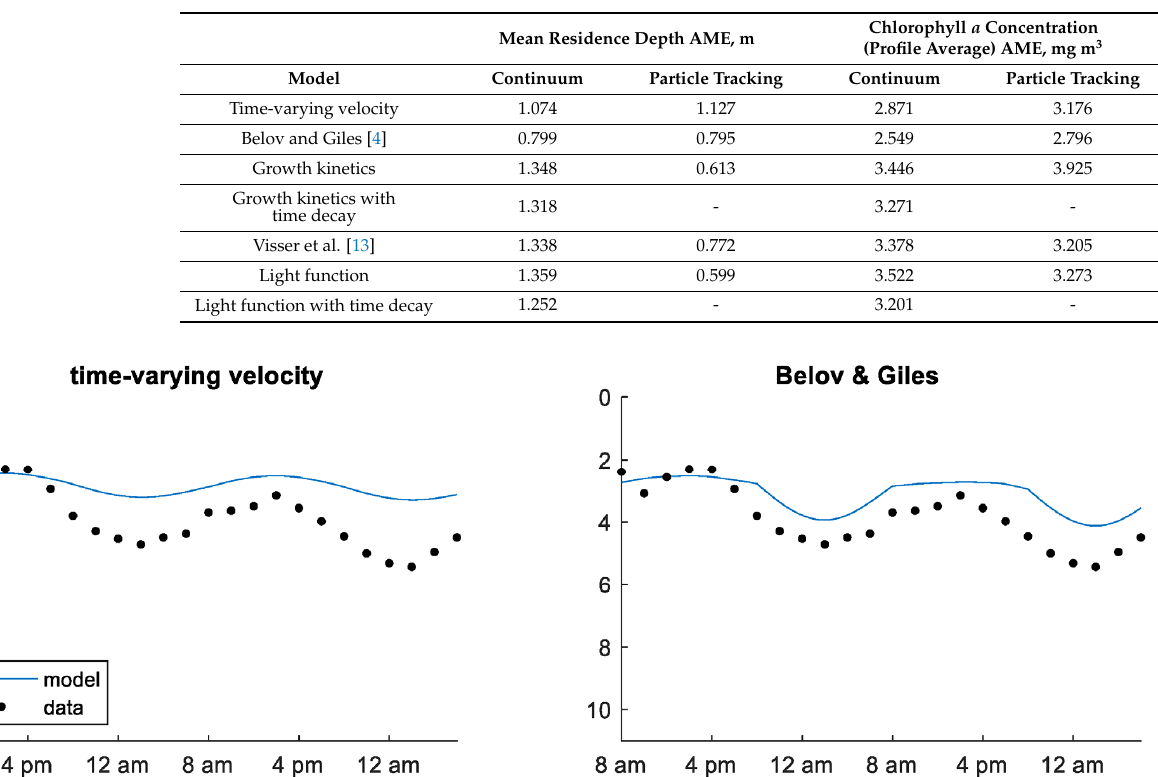
Table 4. Error statistics for models of Shennong Stream enclosure site.